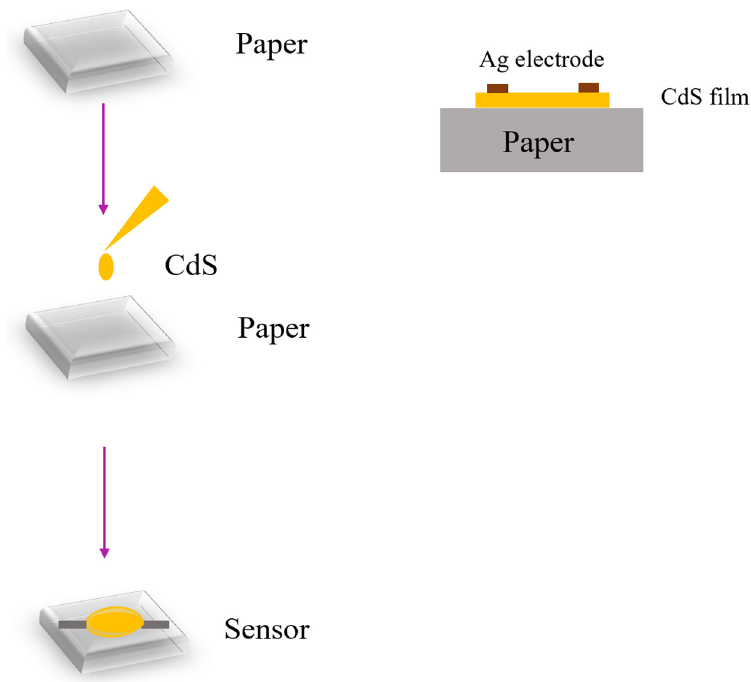
Figure 4. Schematic process flow of CdS semiconductor humidity sensor.